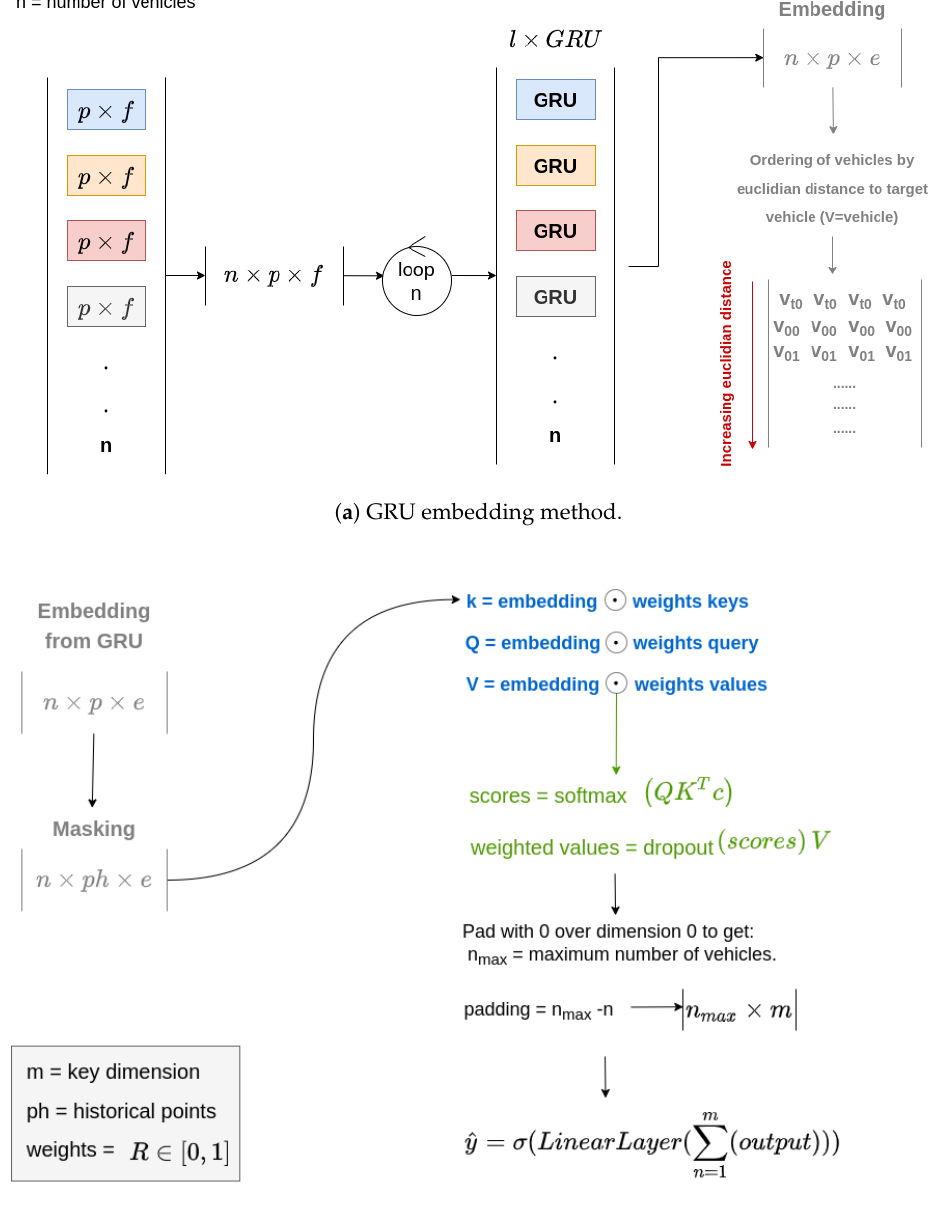
Figure 7. ( a ) GRU embedding method where each vehicle input is iterative fed into the corresponding line model to then generate the embedding matrix with the embedding dimension e. ( b ) Attention decoder for a single embedding shown in figure a. This shows the generation of keys, values and scores as well as the weighting of the and finally the generation of the final